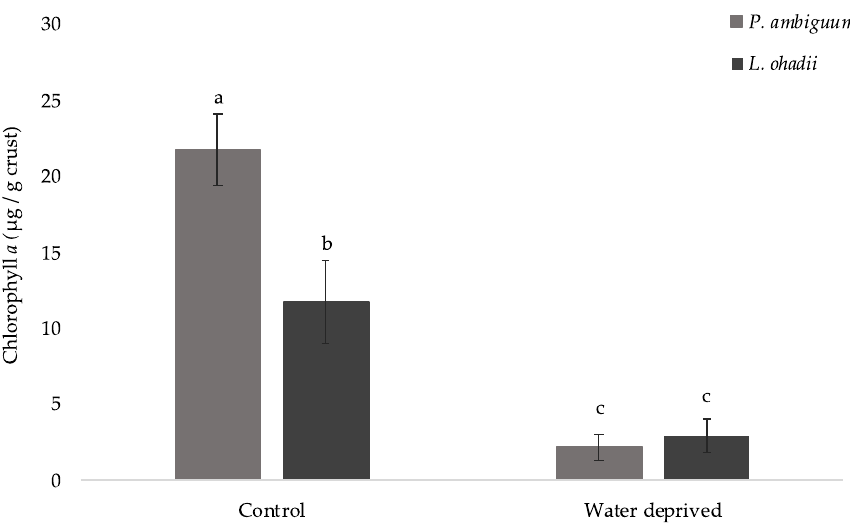
Figure 1 . Chlorophyll a content in cyanobacterial biocrusts (values represent the mean of N = 3, error bars represent SD). Different letters represent significant differences ( p < 0.05).